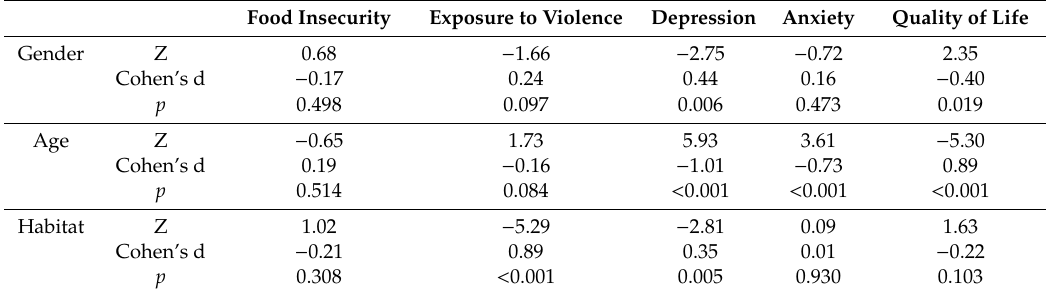
Table 3. Di ff erences by demographics in study